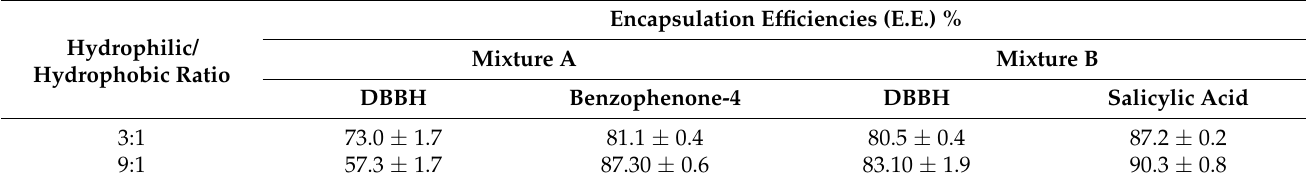
Table 2. Encapsulation efficiency (E.E.) values for different mixtures and different hydrophilic/hydrophobic ratios.